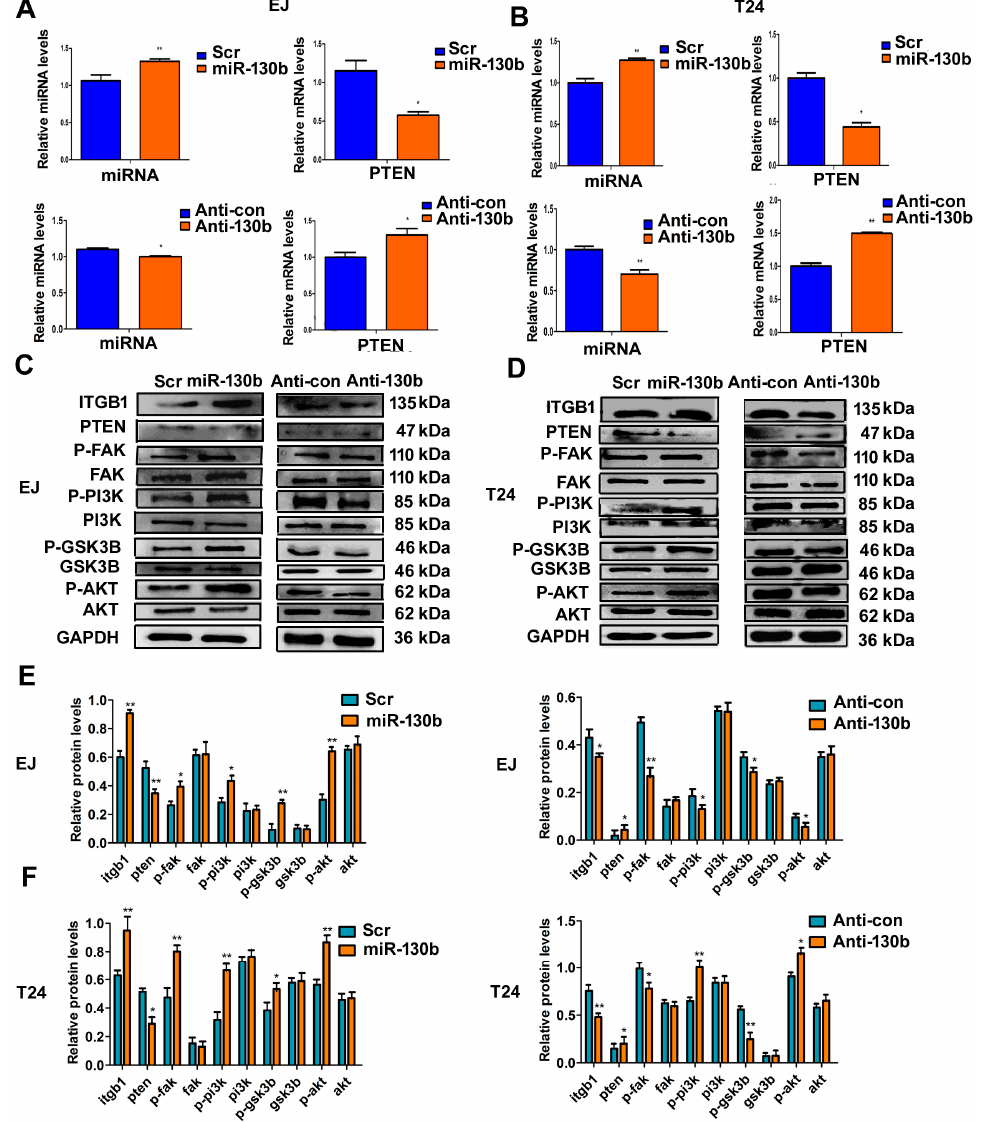
Figure 8. miR-130b-3p affects the expression of PTEN and modulates PI3K/AKT and integrin β 1/FAK signaling pathways. ( A , B ) The relative expression levels of miRNA miR-130b and mRNA PTEN in cells transfected with miR-130b mimics, the scramble control, anti-130b or anti-con by qRT-PCR; ( C , D ) Western blot analysis; and ( E , F ) Quantitative analysis of relative protein levels. Data are expressed as mean ± SD ( n = 3), * p < 0.05, ** p < 0.01.